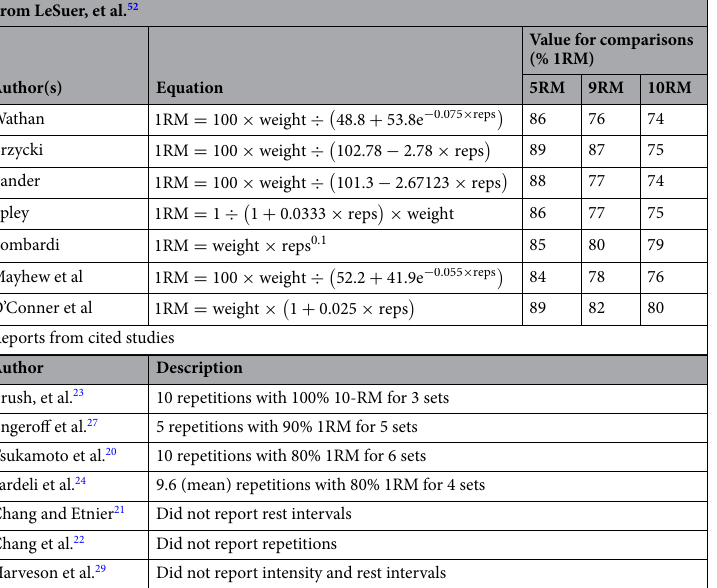
Table 1. Prediction Equations for repetition max (RM) and reports from cited studies. Note that the formulas are used to predict how many repetitions a participant can complete at a given weight for a single